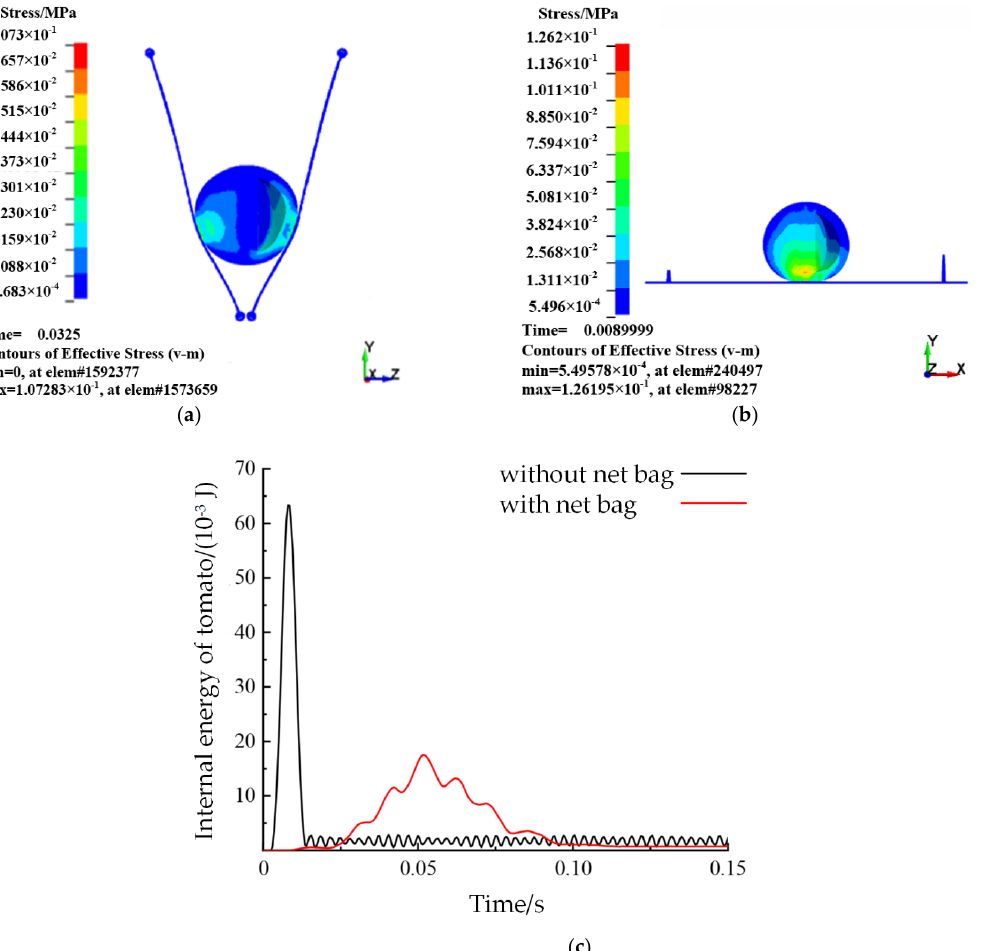
Figure 12. Comparison of the energy absorption effect ( a ) with and without ( b ) the net bag mechanism. ( c ) Comparison of internal energy of tomato when the drop height is 60 mm.